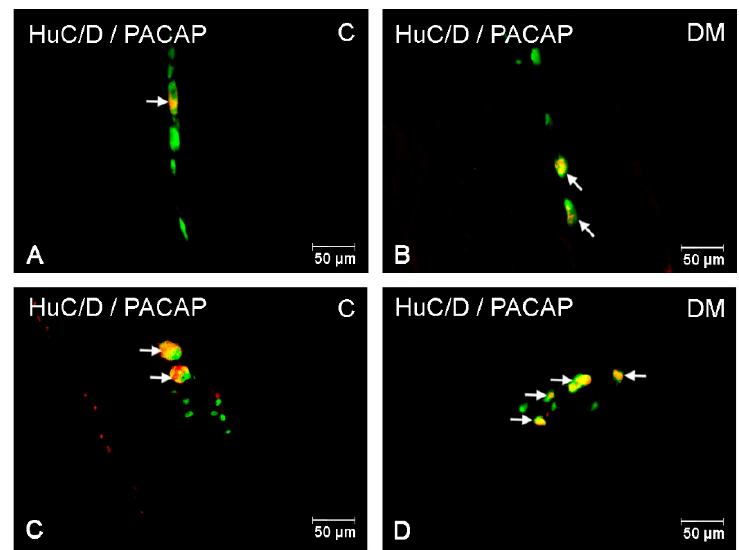
Figure 3. PACAP-LI enteric neurons in the porcine corpus of the stomach. ( A )—neurons immunoreactive to HuC/D (panneuronal marker) and PACAP in the myenteric plexus of control pigs; ( B )—neurons immunoreactive to HuC/D (panneuronal marker) and PACAP in the myenteric plexus of diabetic pigs, ( C )—neurons immunoreactive to HuC/D (panneuronal marker) and PACAP in the submucous plexus of control pigs; ( D )—neurons immunoreactive to HuC/D (panneuronal marker) and PACAP in the submucous plexus of diabetic pigs. All pictures were created by digital superimposition of two colour channels (green for HuC/D and red for PACAP).